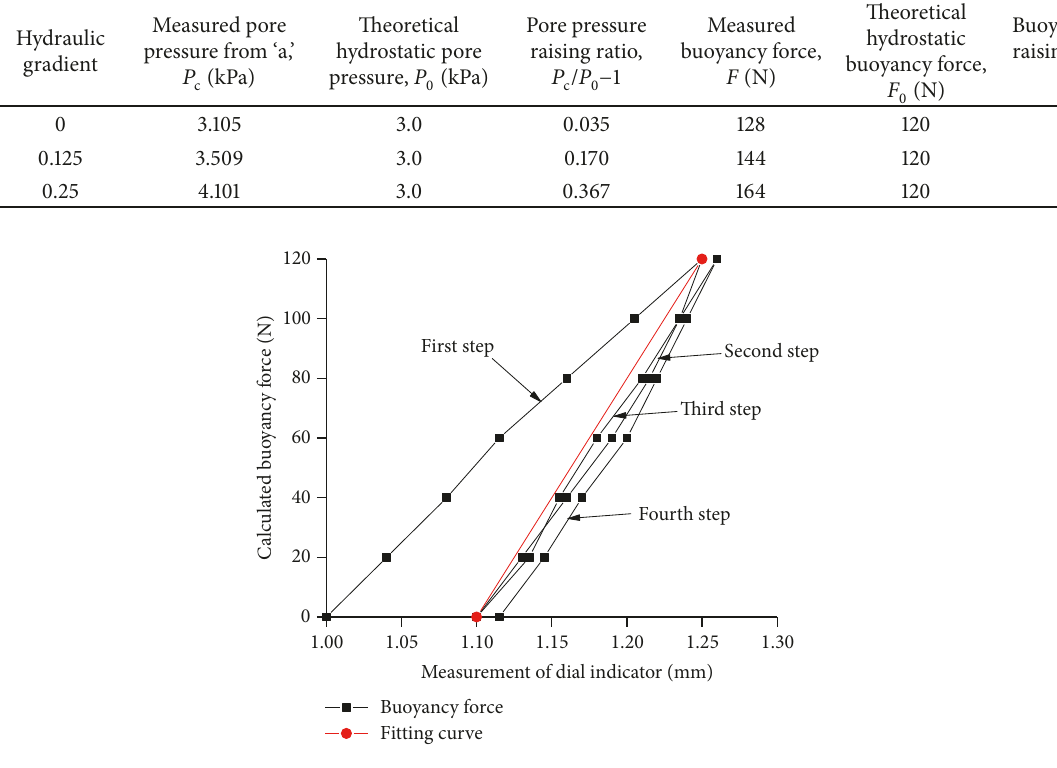
Figure 5: Calibration result of the buoyancy